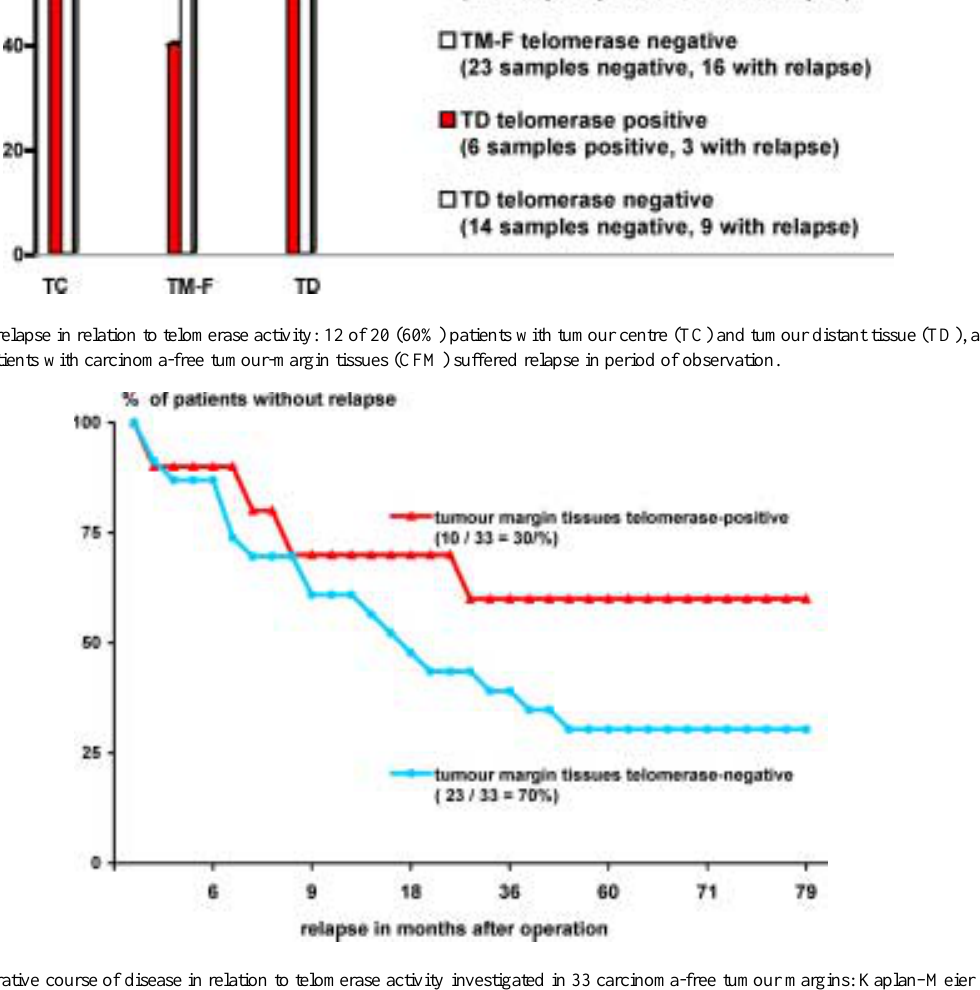
Fig. 4. Postoperative course of disease in relation to telomerase activity investigated in 33 carcinoma-free tumour margins: Kaplan–Meier curve (Log Rank p = 0 .